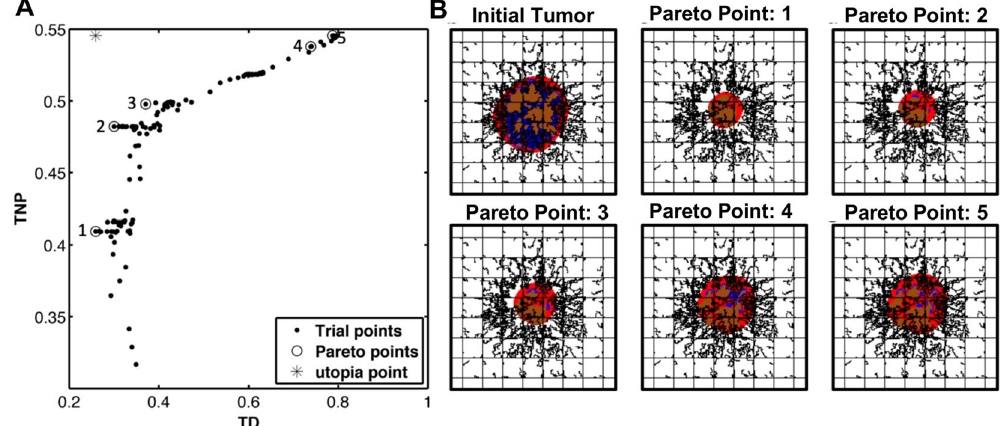
Figure 3. Solution of the multiobjective optimization problem. ( A ) Trial points selected by MADS to generate the Pareto front. ( B ) Display of the tumor at treatment initiation and after treatment using the optimal designs identified (quantified in Table 2), respectively showing a decrease of 74%, 70%, 63%, 26% and 21% in tumor diameter ratio (TD). The corresponding nanoparticle accumulation in the treated tumors (TNP) is 41%, 48%, 50%, 54% and 55%, respectively. Colors are as in Fig. 1.